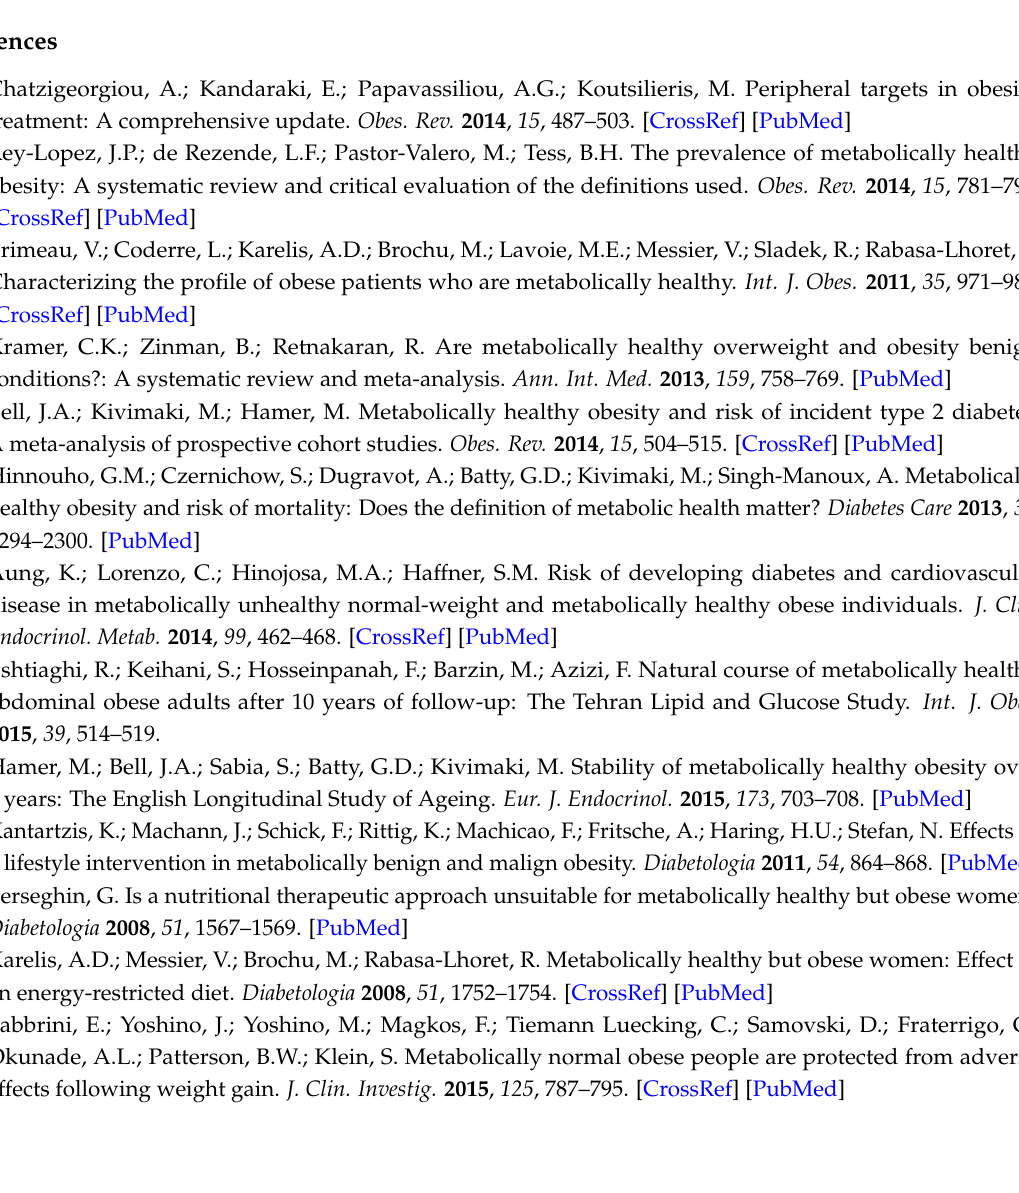
Table S1: The comparison of the baseline characteristics of the people participated in follow-up examinations and lost to follow